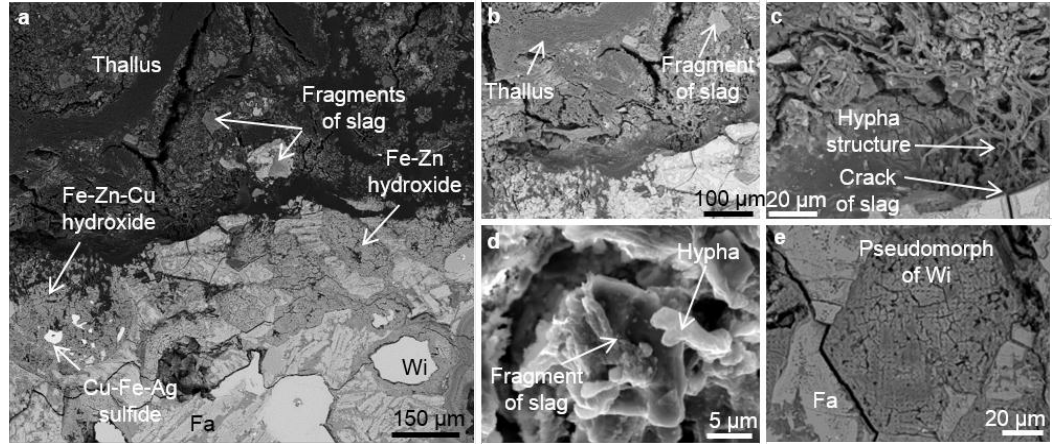
Figure 2. Back-scattered electron images of ( a ) lichen-slag interface; ( b ) slag fragments caught by hyphae structure; ( c ) hyphae penetrating crack of slag; ( e ) etch-pits of pseudomorph of willemite; and ( d ) a secondary electron image of slag fragments caught by hyphae structure. W-Wi: weathered willemite; Wi: willemite; Fa: fayalite.